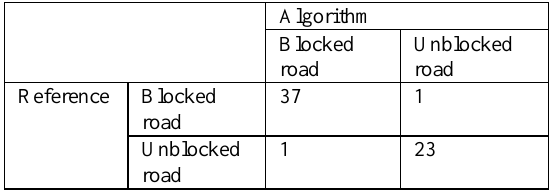
Table 3. Comparison between the destruction maps from visual interpretation and the suggested